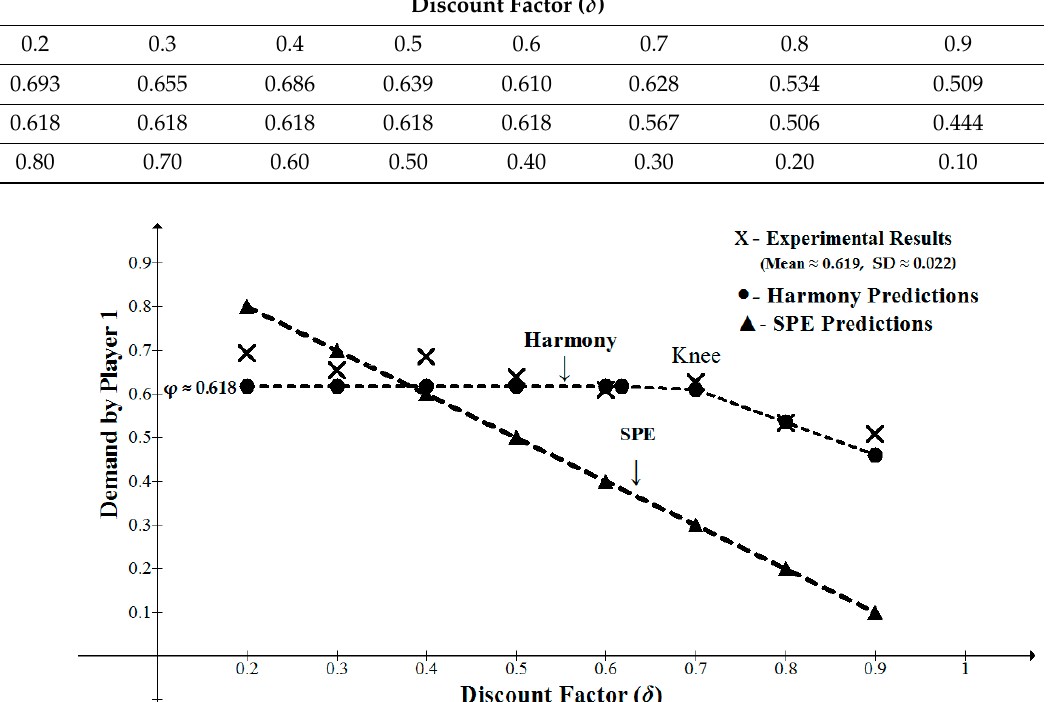
Figure 1. Experimental and theoretical opening demands by Player 1 for the Binmore et al., 2002 study, as functions of the discount factor δ .